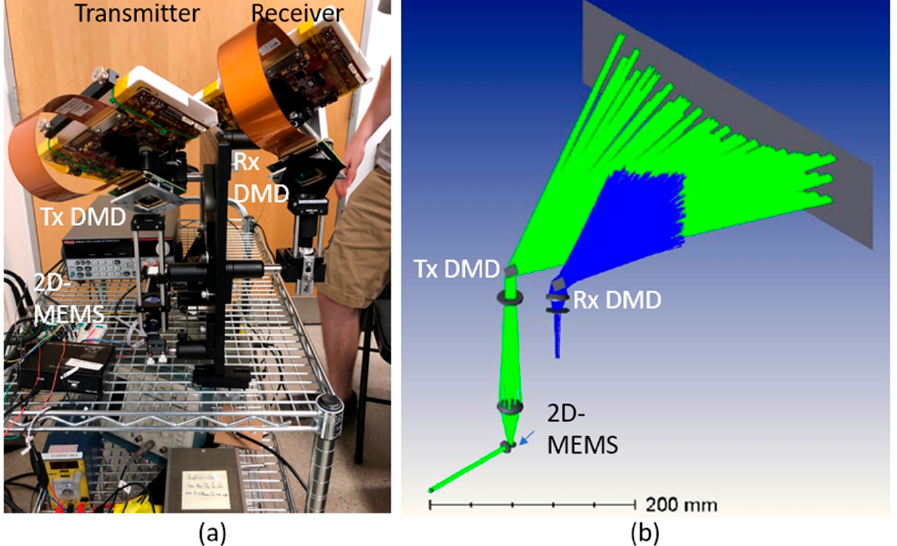
Figure 5. ( a ) Photograph and ( b ) a ray-tracing diagram of the lidar transmitter and receiver.